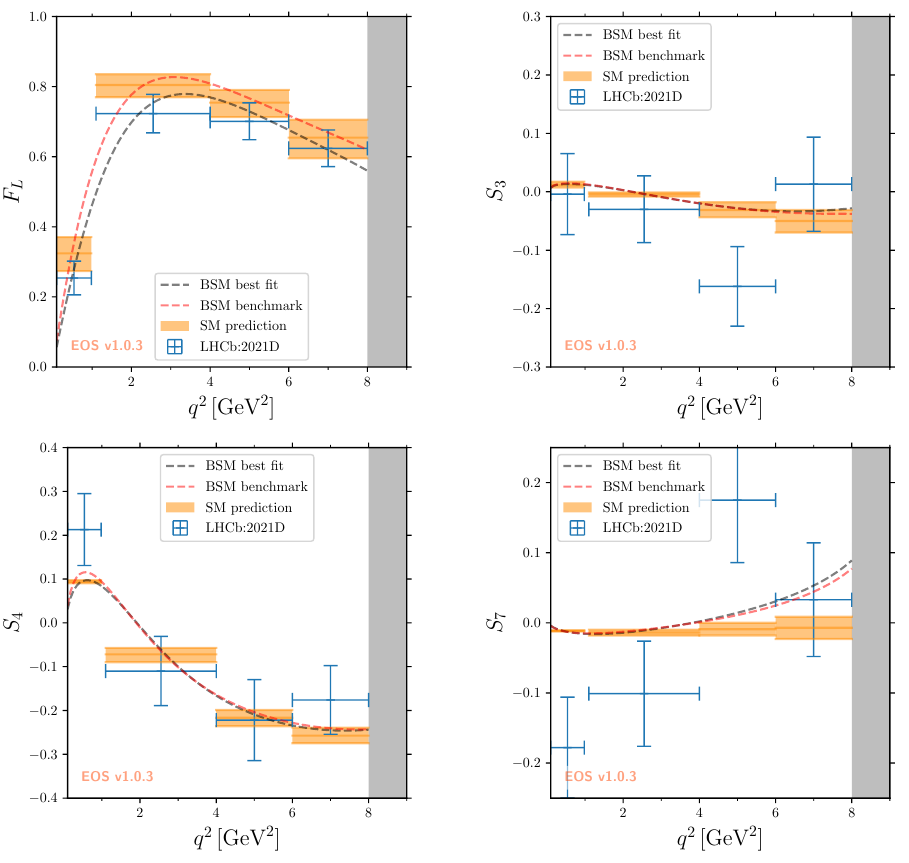
Figure 7 . SM predictions for the angular observables of the B s → φµ + µ − decay. Our SM predictions are also given in table